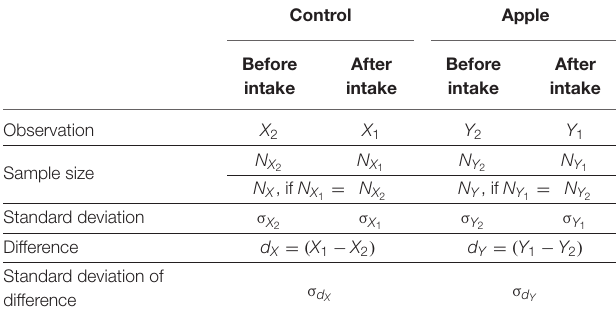
TABLE 1 | Notations for characteristic value.